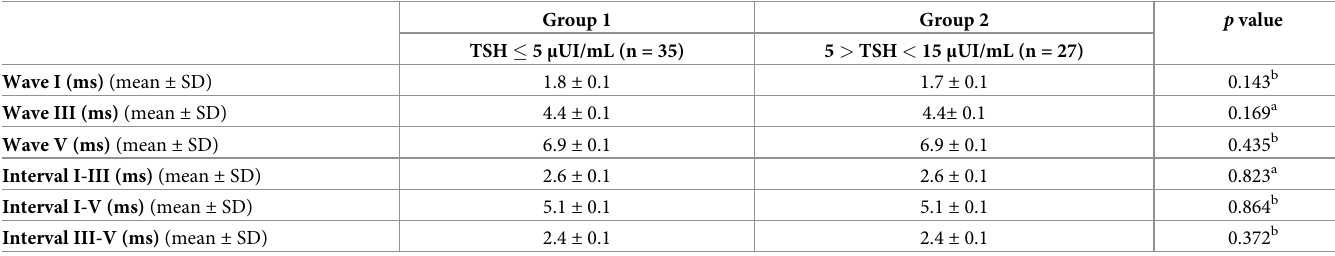
The scatter plot graphs of TSH levels vs. wave and interval latencies are depicted below (Fig 1).